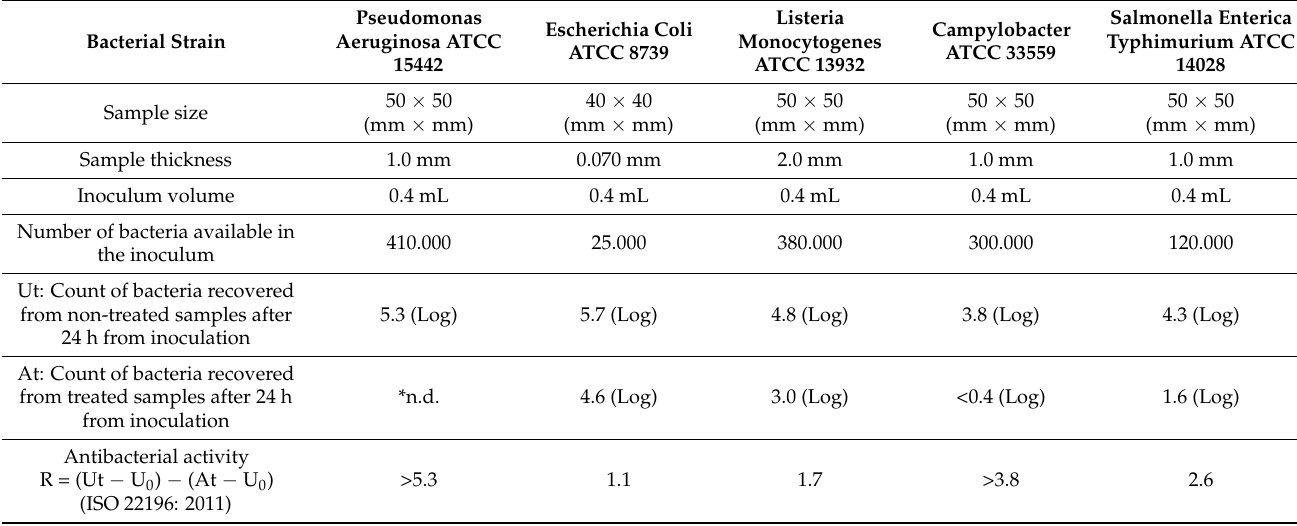
Table 3. Inhibition of Pseudomonas, Escherichia coli, Listeria, Salmonella, and Campylobacter from the Nylon/PE-Active Filler pouches according to the directive ISO 22196: